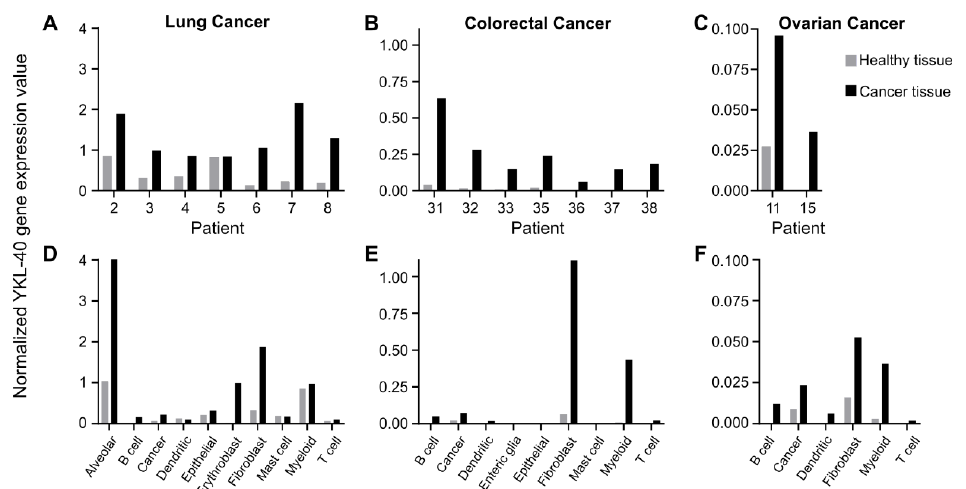
Figure 1. ScRNAseq data from patients with lung, colorectal, and ovarian cancer. Seurat-based normalized YKL-40 gene expression value comparing healthy tissue with cancer tissue in ( A – C ) individual patients and in ( D – F ) cell subsets for: lung ( n = 7), colorectal ( n = 7), and ovarian cancer ( n = 2) (E-MTAB-8107). For gene annotation of cell populations, please refer to Qian et al. [25].